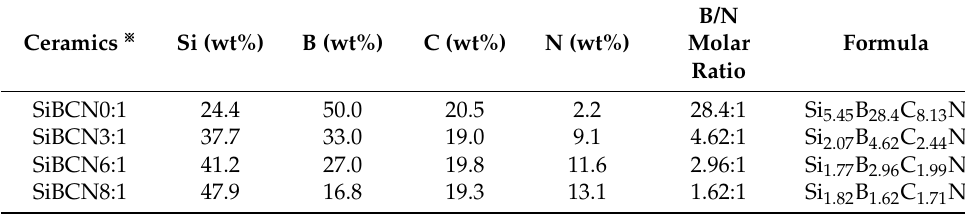
Table 1. Elemental composition of the ceramics pyrolyzed at 1000 ◦ C under N 2